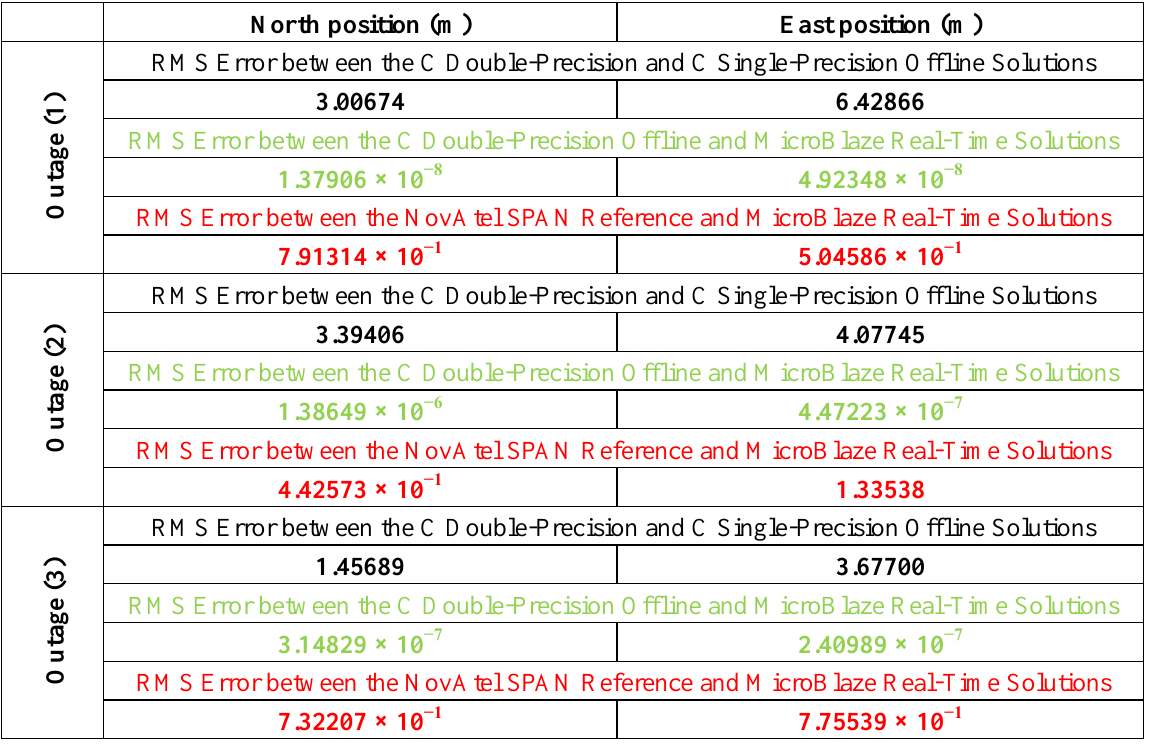
Table 6. RMS Error in the Latitude and Longitude Solutions over the Four Outages introduced in Mobile Robot Trajectory